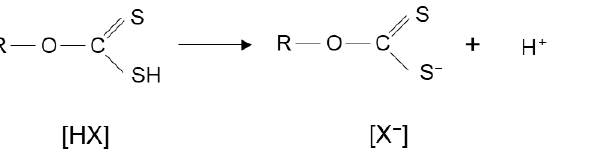
Figure 12. Chemical structures of xanthates. [HX]: xanthic acid, [X − ]: xanthate anion. R: hydrocarbon group (adapted from Somasundaran et al. [35]).